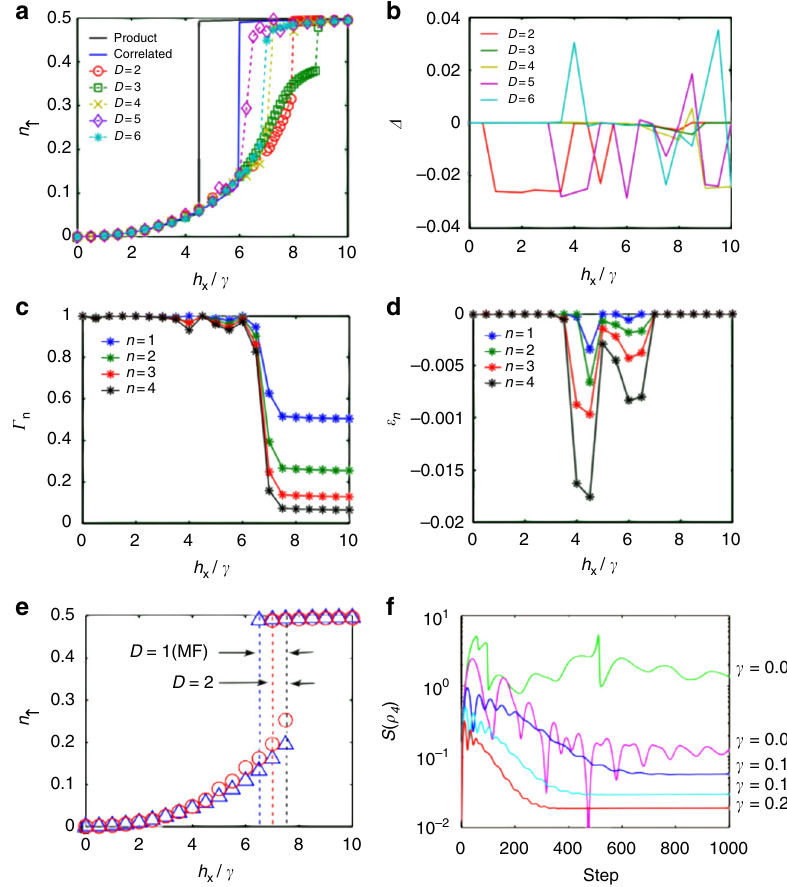
Fig. 2 Computed quantities. a Spin-up density in the steady state as a function of h x / γ for V = 5 γ , γ = 0.1 and h z = 0, as computed with our method up to D = 6. For comparison, we show the results previously obtained by the variational method[12] with product states (black line) and correlated states (blue line); ( b ) Δ up to D = 6; ( c ) Purity Γ n of the reduced density matrix for a block of n contiguous spins, for D = 6 (other bond dimensions have similar behavior). Spins are chosen within the 2 × 2 unit cell of the tensor network; ( d ) ε n of the reduced density matrix for a block of n contiguous spins, for D = 6 (other bond dimensions have similar behavior). Overall, the convergence can be further improved by using more accurate update schemes; ( e ) bistable region for D = 1 (mean fi eld) and D = 2. The region shrinks and disappears for larger bond dimension; ( f ) operator-entanglement entropy throughout the algorithmic evolution for a block a 2 × 2 unit cell with D = 2, V = 0.5, h x / γ = 10, and different values of γ . The stronger the dissipation, the weaker the entanglement. A similar behavior is observed for larger